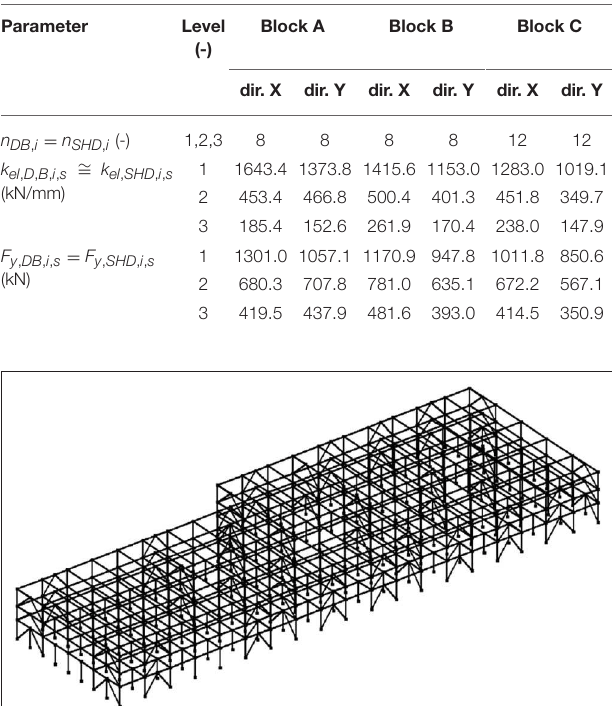
The Rigid links (RLs), provided to connect the SHDs to the